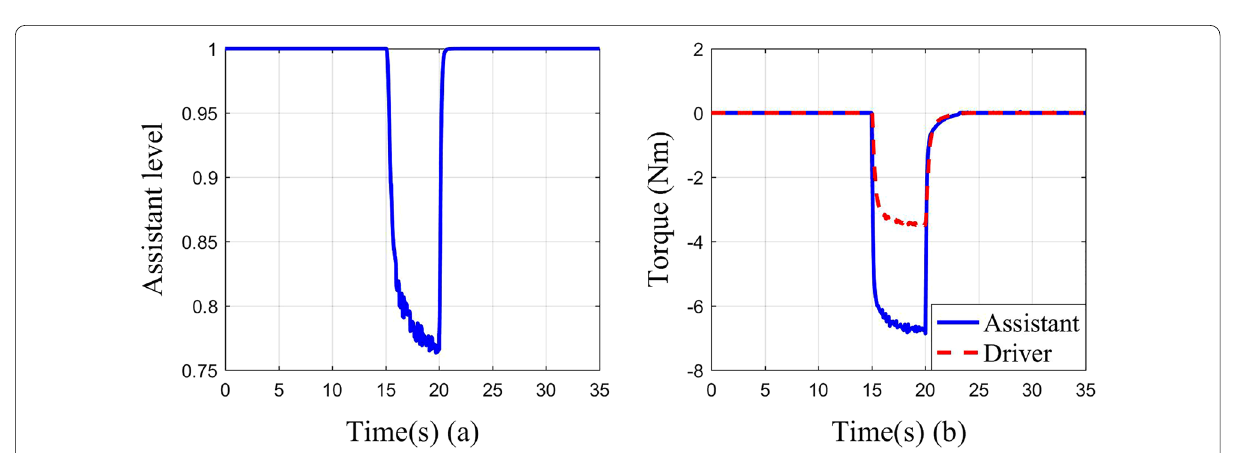
Figure 5 a Assistance level according to driver’s activity, b the driver torque and the assistance